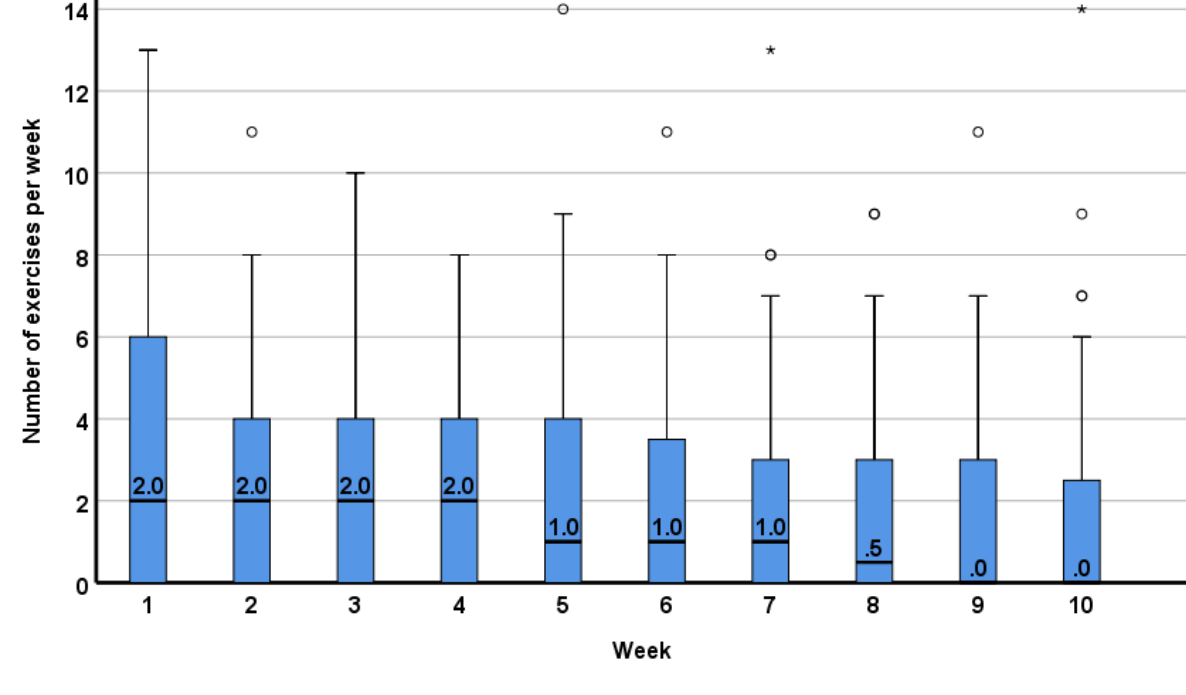
Figure 2. Completed app exercises by all patients who were enrolled in the study (N=100) per week (median, interquartile range).